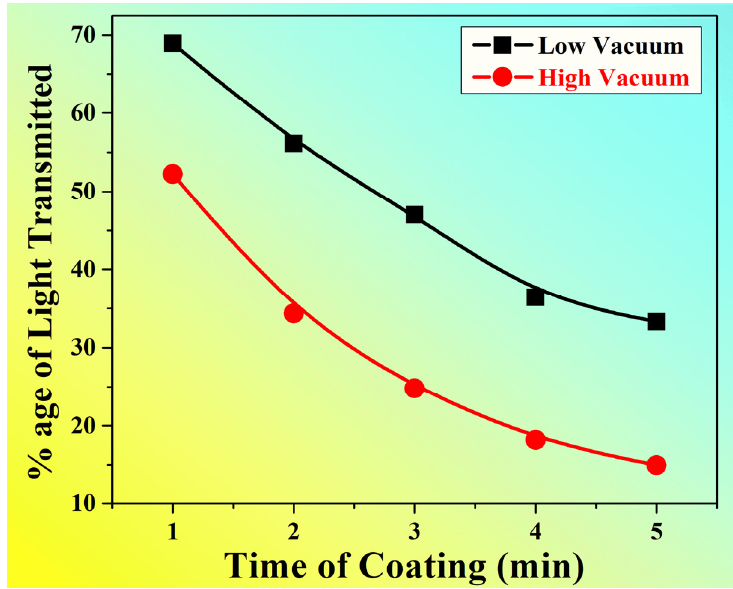
Figure 4. Comparison of Sputtered Coatings at Different Vacuum. At constant high vacuum pressure of 10 − 1 torr, Figure 5 depicted the effect of applied voltage on the percentage of light transmittance as a function of time. At 1 min, the percentage of light transferred at high applied voltage is 44 percent, whereas at low applied voltage, the percentage of light transmitted is 53 percent. These findings indicate that at high voltage, a more uniform coating is obtained. This is demonstrated in Figure 5 by comparing the curves obtained at low voltage “0.9 KV” and high voltage “1.45 KV” at constant high vacuum pressure “10 − 1 torr”.